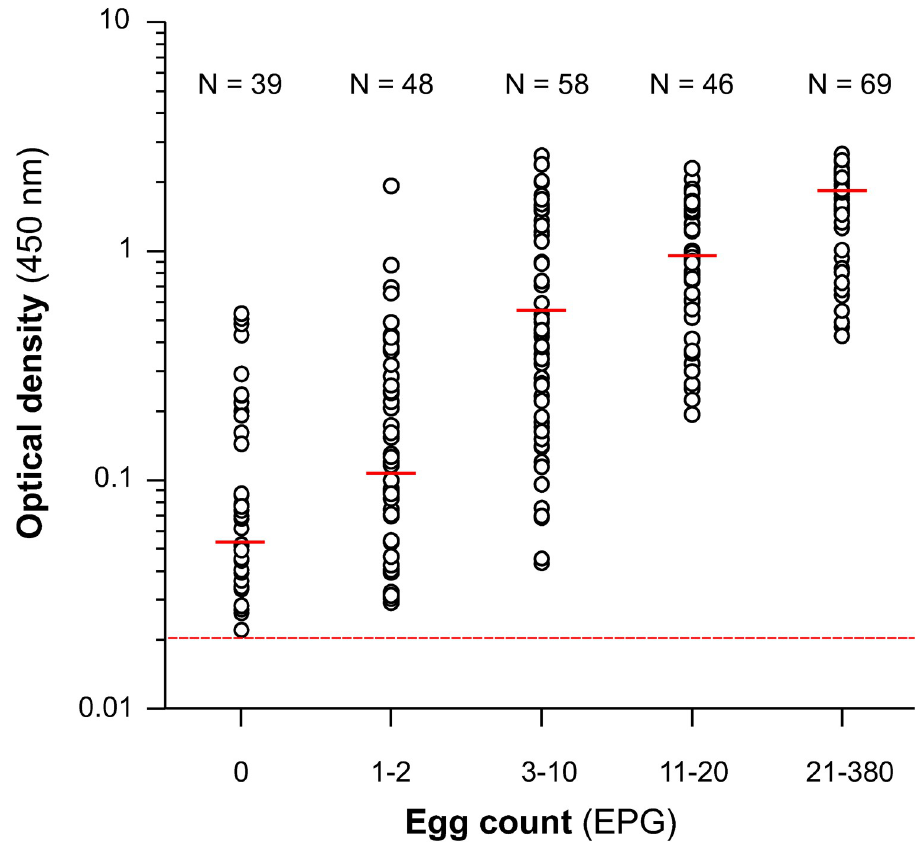
Fig 6. Individual optical density values for the sheep diagnosed as positive by eMM3-COPRO test. Data (n = 260) were clustered into 5 categories based on the faecal egg count. For each category, the median values are represented by a solid horizontal red line. The dashed red line indicates the cut-off value